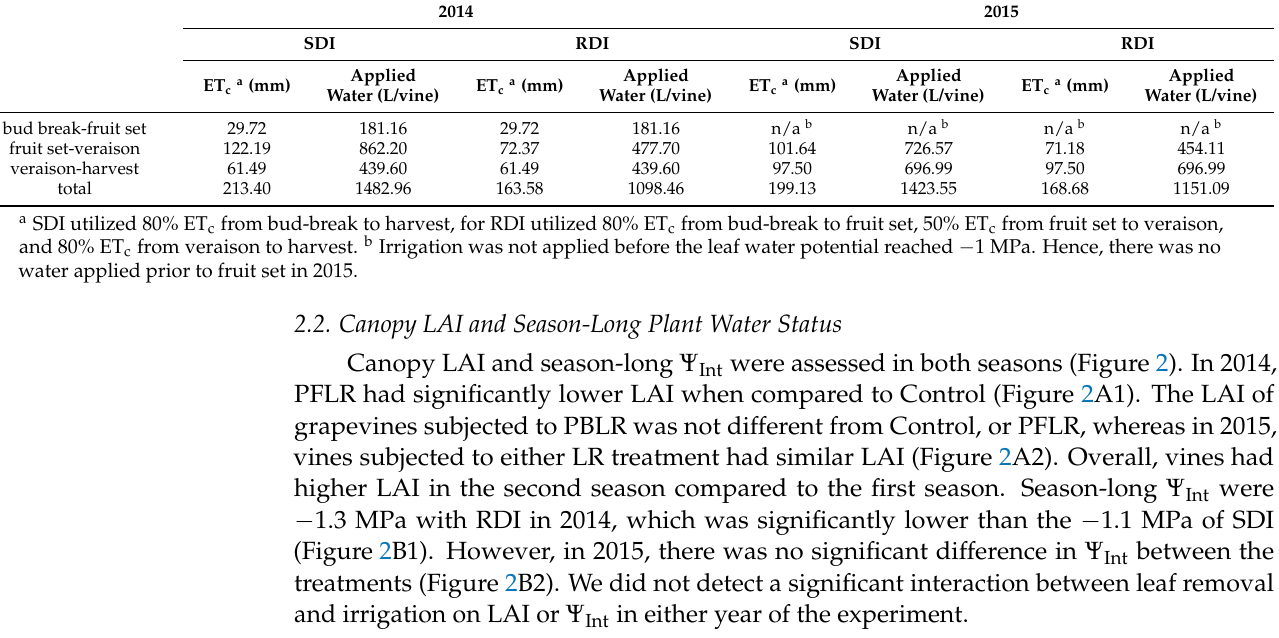
Table 1. Crop evapotranspiration (ET c ) and applied water amount between two irrigation regimes in a Merlot vineyard in Denair, California in 2014 and 2015.